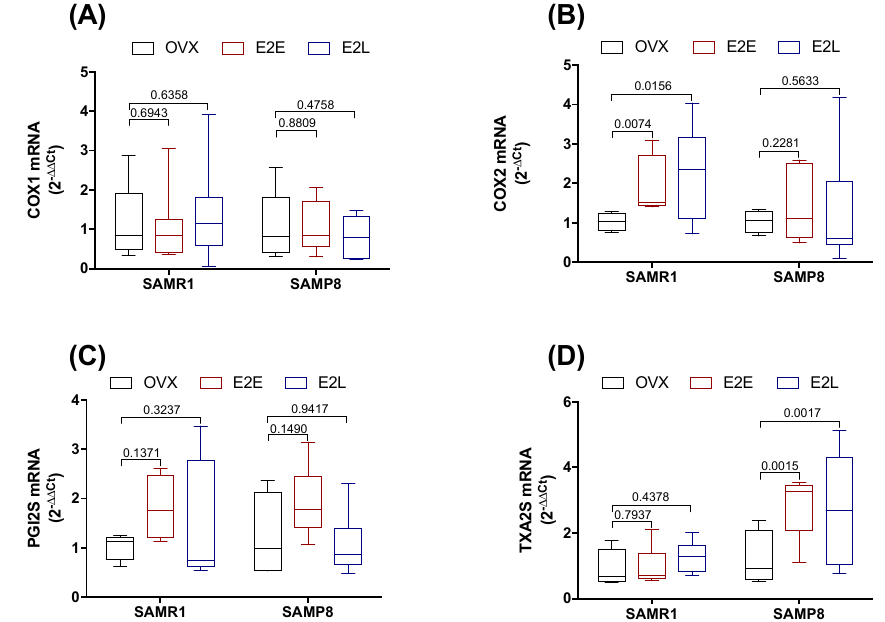
Figure 4. mRNA expression in cyclooxygenase cascade. COX-1 ( A ), COX-2 ( B ), PGI2S ( C ), and TXA2S ( D ) expression in common carotid artery of SAMR1 and SAMP8 normalized by β -actin mRNA and relative to the expression of untreated OVX mice. Total RNA was obtained in vessels from untreated ovariectomized female mice (OVX), OVX mice receiving early-onset 17 β -estradiol treatment (E 2 E), and OVX mice receiving late-onset 17 β -estradiol treatment (E 2 L). Each point represents the mean ± SEM from 5–10 independent experiments. One-way ANOVA analyzed the dependence of data on the onset of estrogen therapy (none, early, or late) in SAMR1 or SAMP8 with Bonferroni’s post-test. p -values and comparisons are expressed on top of bar graphs. Significance is considered when p < 0.05.